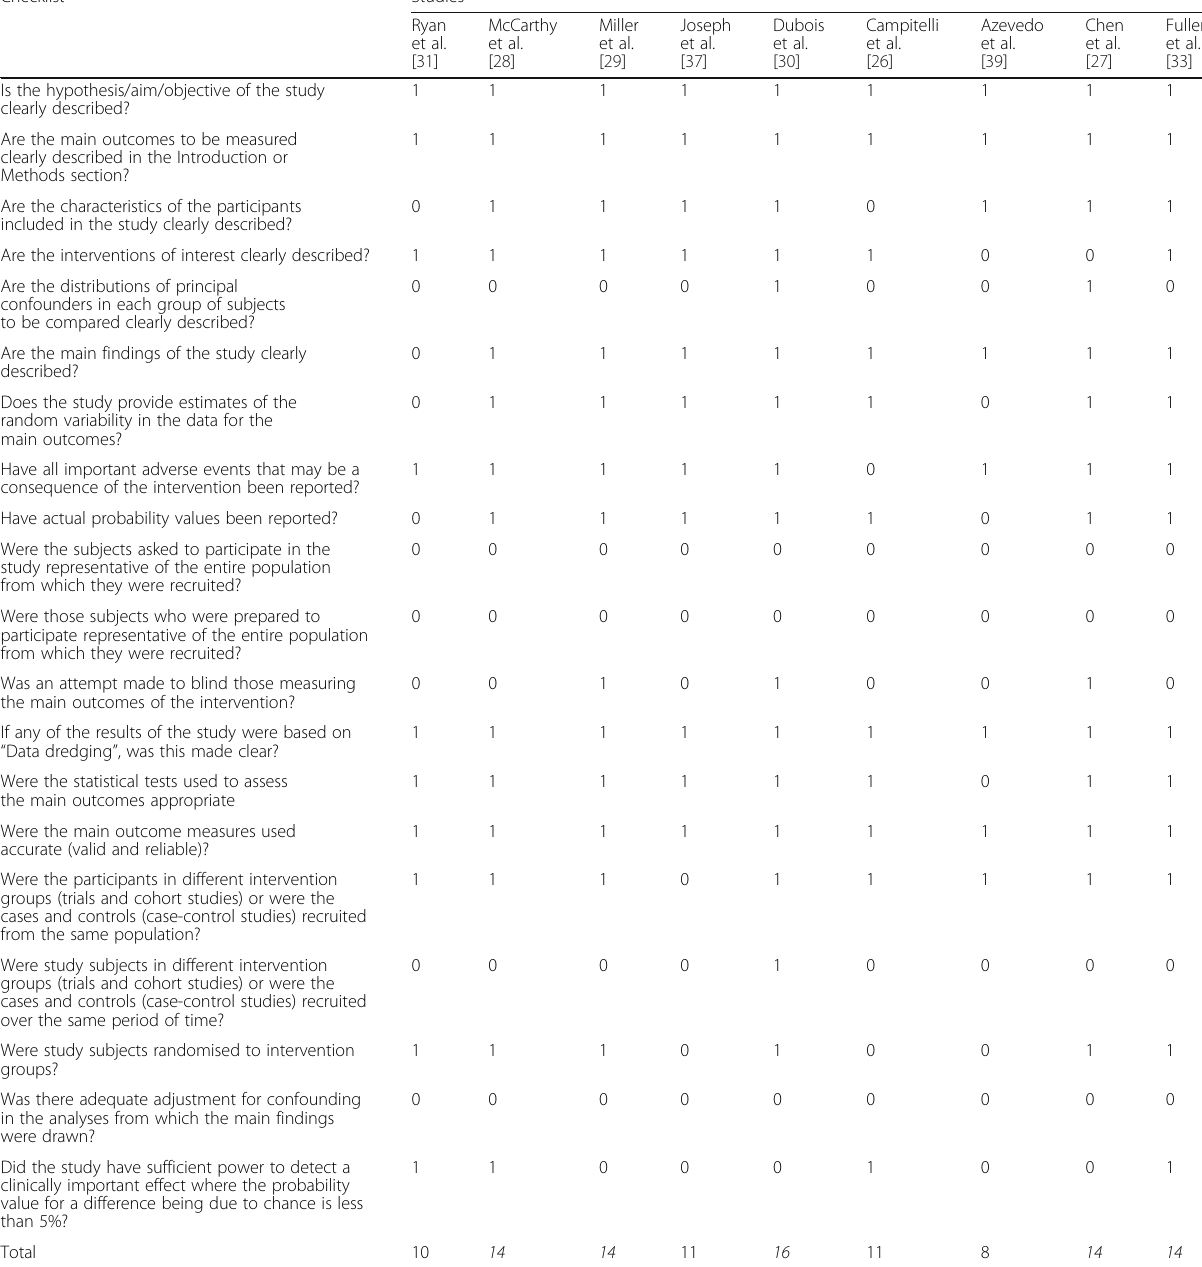
Table 2 Modified Downs and Black ’ s checklist results. The scale was composed of 20 items related to information reporting (items 1 to 9), external validity (items 10 and 11), internal validity (items 12 to 15), and selection bias (items 16 to 20). Each item was scored 0 to represent a high risk of bias or 1 to represent a low risk of bias. Studies that scored a total of 0 to 6 were classified as “ high risk of bias ” , from 7 to 13 as “ moderate risk of bias ” , and from 14 to 20 as “ low risk of bias ”